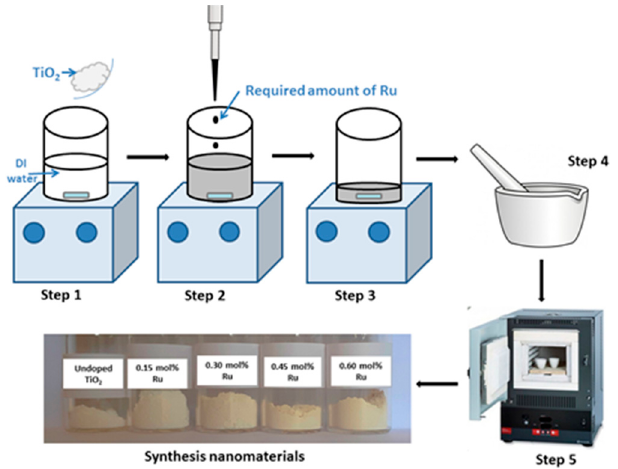
Figure 1. Schematic diagram of the synthesis of Ru-doped TiO 2 nanomaterial.